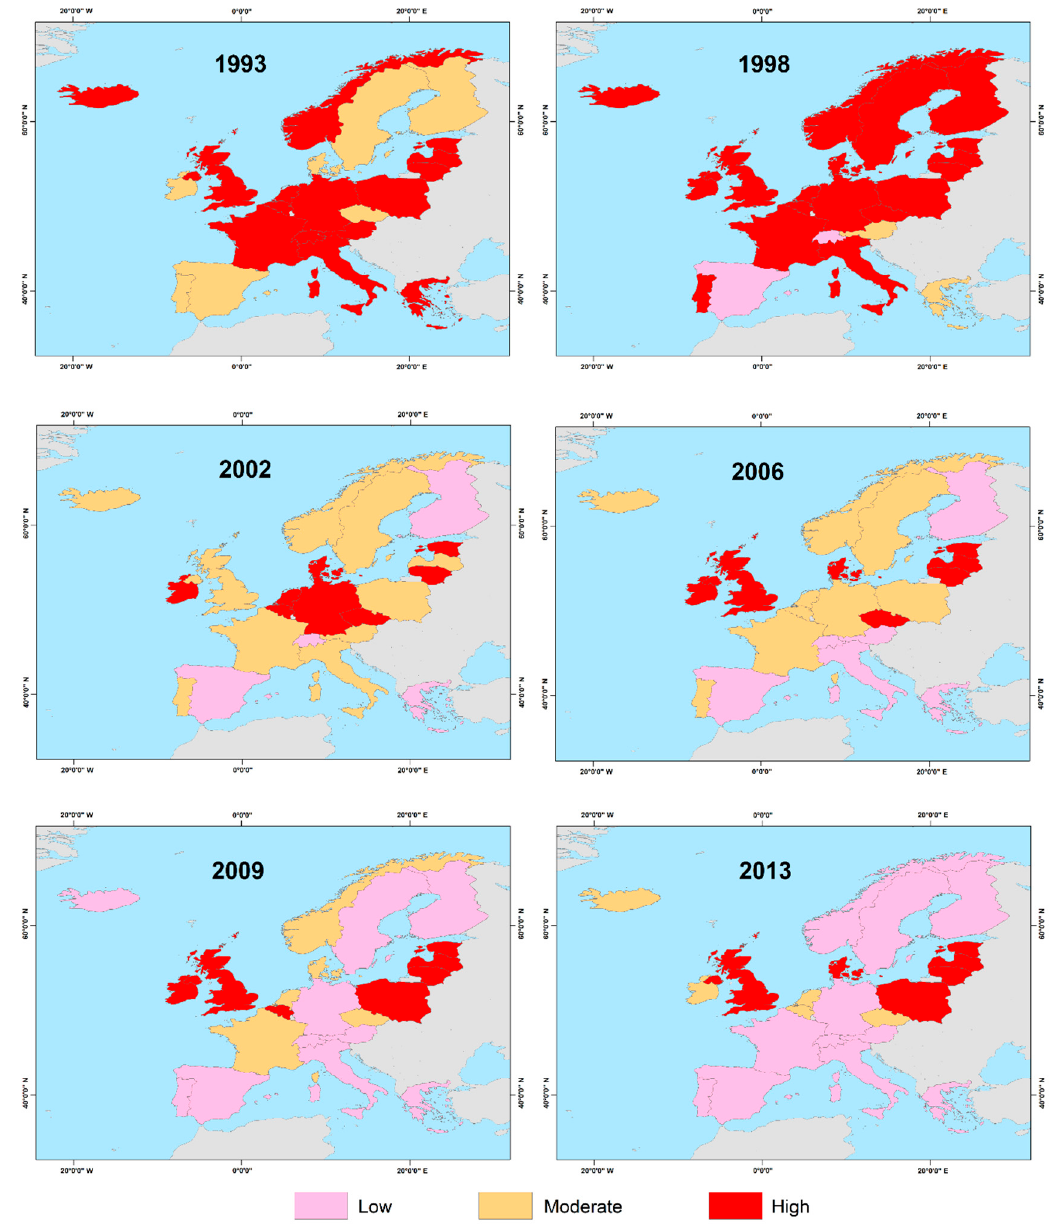
Figure 9. Individual unexpected mortality (parameter κ ) for female gender in 1993, 1998, 2002, 2006, 2009, and 2013.